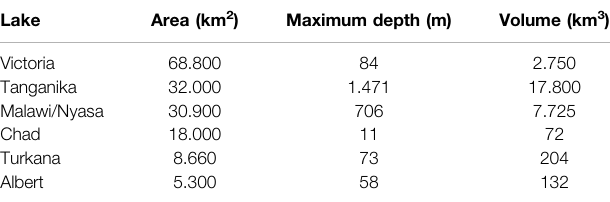
TABLE 2 | Largest lakes in Africa adapted from Shiklomanov and Roda (2004).